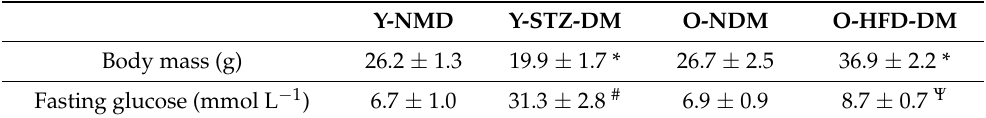
Table 1. Body mass and fasting glucose concentrations of 13-week-old non-diabetic mice ( n = 9) (young non-diabetic mice, Y-NDM), 13-week-old STZ-induced diabetic mice ( n = 9) (Y-STZ-DM), 54-week-old old (O) non-diabetic mice ( n = 9) (O-NDM), and 54-week-old HFD-induced obese insulin-resistant mice ( n = 9) (O-HFD-DM).